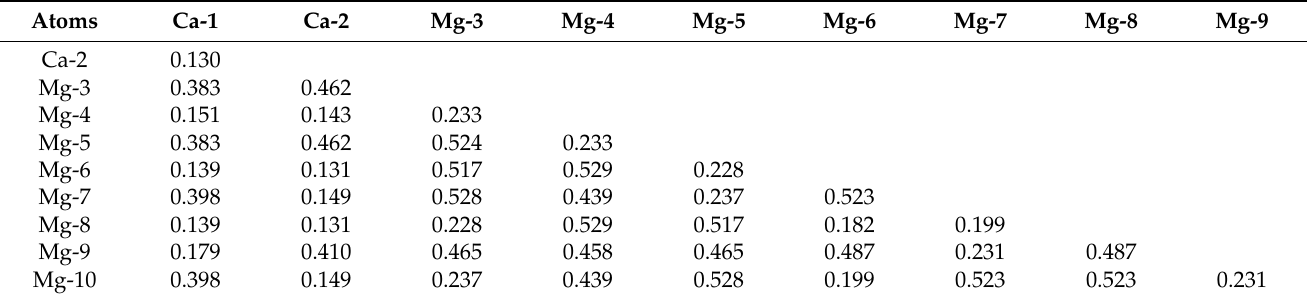
Table 3. The Wiberg bond orders of the Ca 2 Mg 8